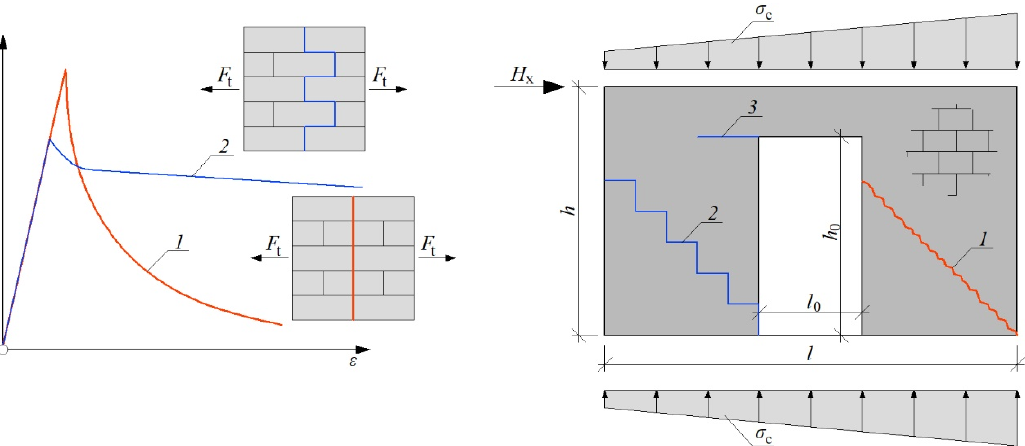
Figure 1. Behavior of stiffening masonry wall in simple and complex failure mode; 1— straight crack (high compressive stress); 2 —stepped crack (low compressive stress); 3 —tensile corner; s c — compressive stress; s t — tensile stress; H x —horizontal shear force; F t —tensile force.